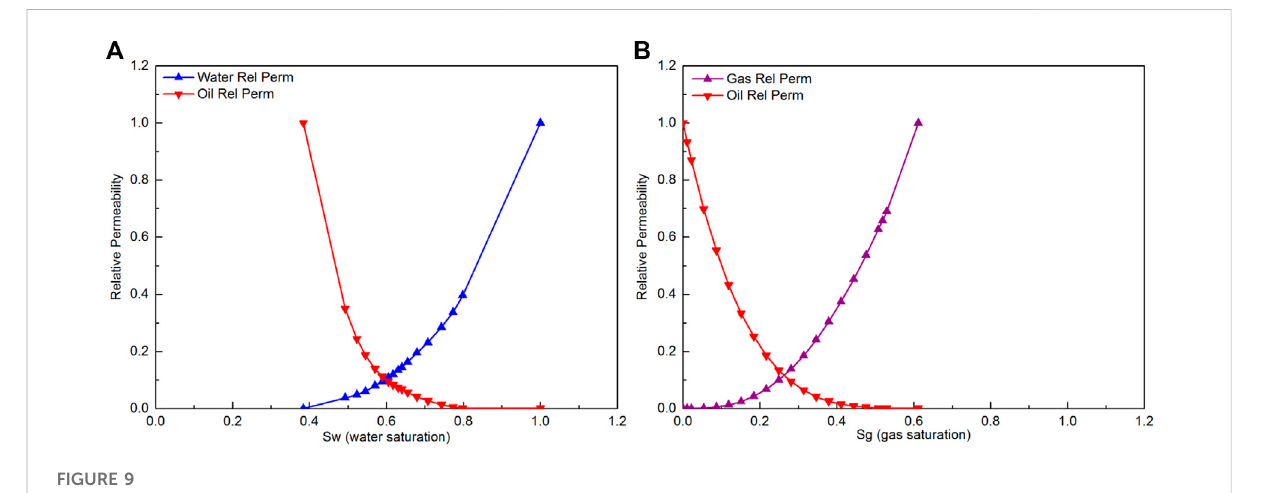
FIGURE 9 Relative permeability